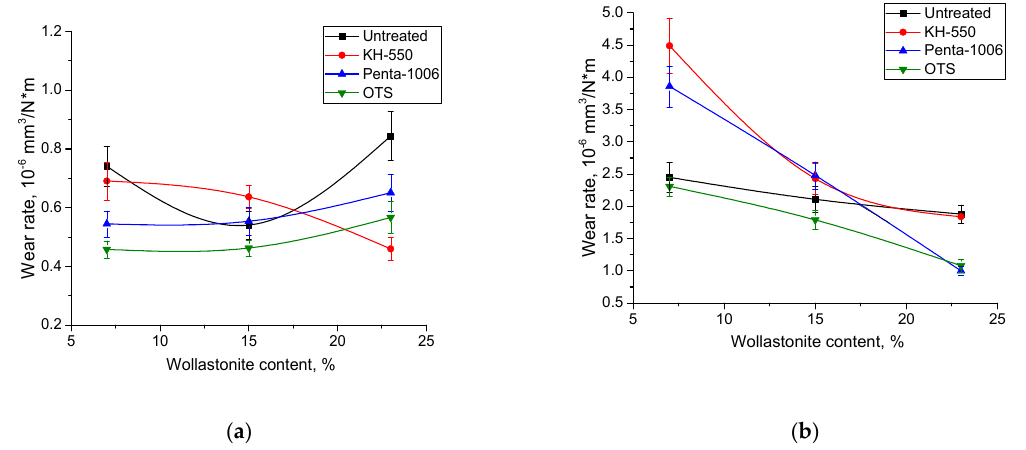
Figure 7. Diagrams on wear rate vs. filler weight fraction for the UHMWPE-based composites for ( a ) Load = 60 N, Velocity = 0.3 m ∙ s − 1 and ( b ) Load = 140 N, Velocity = 0.5 m ∙ s − 1 : the “block-on-ring” scheme.